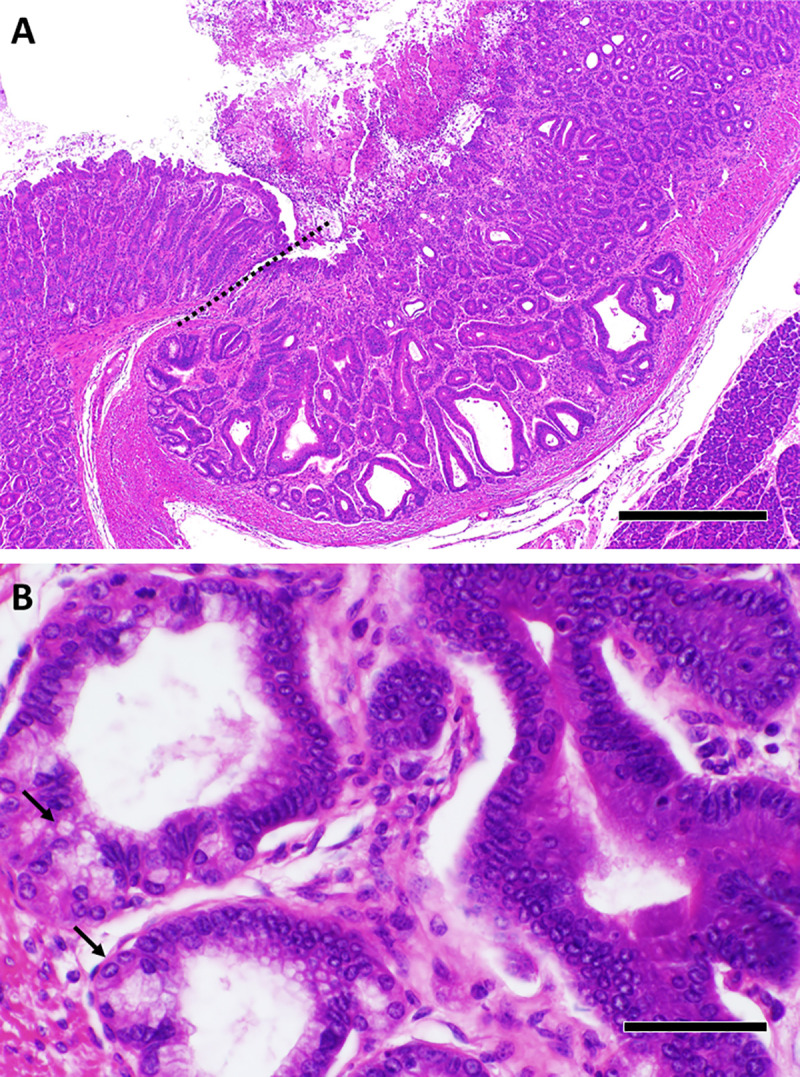
Colonic metaplasia of Brunner’s glands and duodenal inflammation in TIA mice.A. The pyloric region of the glandular stomach (left of dashed line) and the duodenum (right of dashed line) are shown. The duodenal mucosa demonstrates mucosal epithelium and Brunner’s glands with loss of villous architecture and histology similar to that seen in the colon (colonic metaplasia). B. A higher magnification views demonstrates the metaplastic epithelium and surrounding lamina propria and submucosa with marked chronic and active inflammation, similar to what was observed in the colon of these mice. Images shown are from a 9 week mouse, where some residual cells (arrows) exhibit morphology typical of Brunner’s glands. Older mice with such metaplasia typically lacked residual identifiable Brunner’s glands. Scale bar represents 500 μm in A and 50 μm in B.